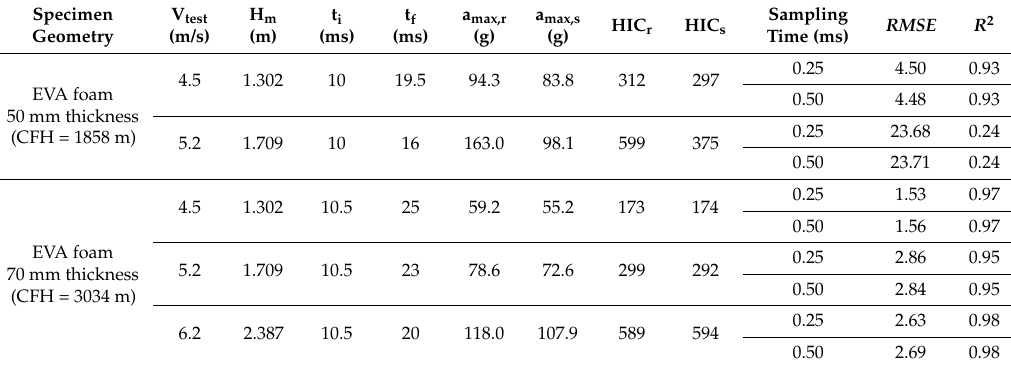
Figure 6. Experimental and simulated acceleration curves of the missile impacting the EVA 70 mm pad with initial velocities equal to 4.5 m/s, 5.2 m/s, and 6.2 m/s. Table 2. Collected data from the impact test, the simulation outputs, and the statistical analysis. EVA: ethylene-vinyl acetate; HIC: head injury criterion.